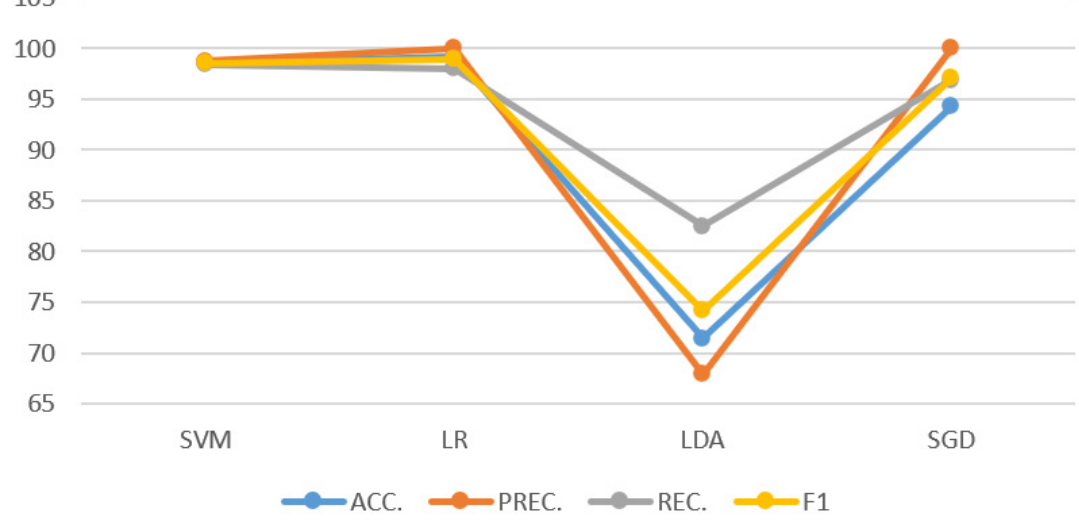
Figure 9. Performance of LR classifier on DenseNet201 features.